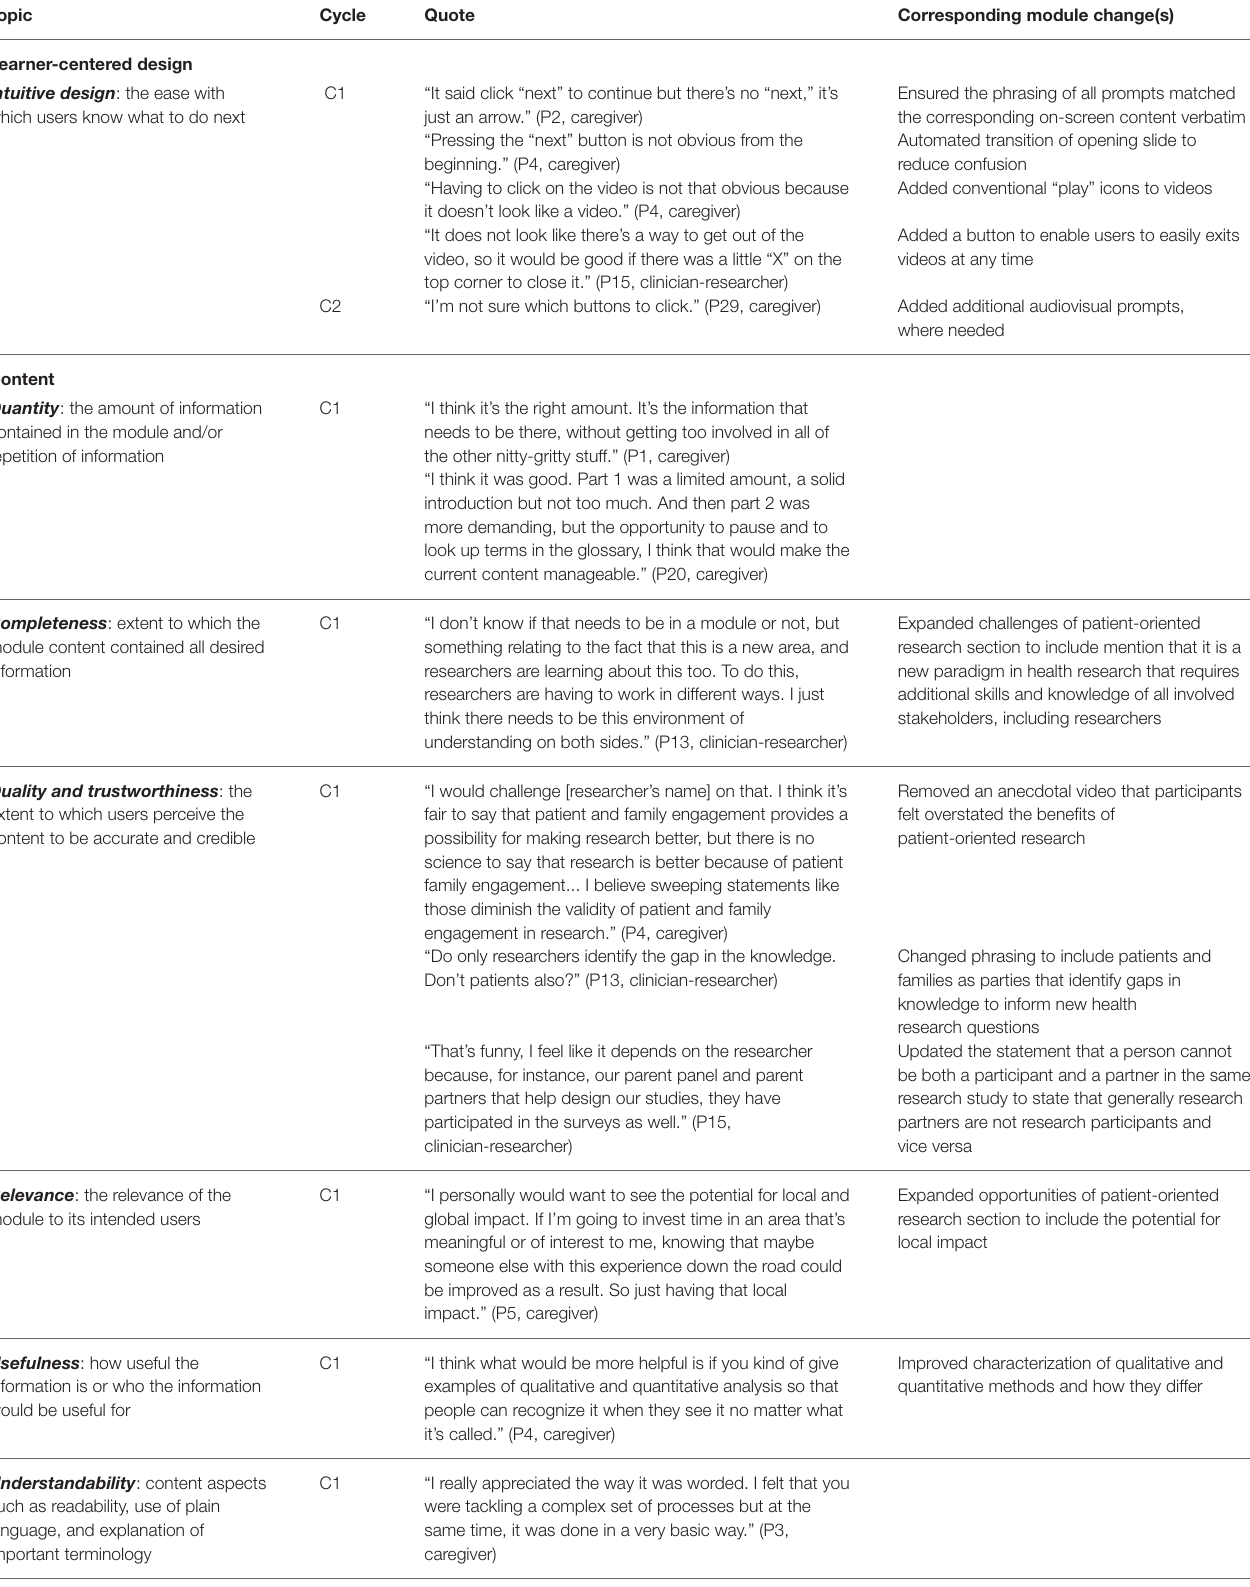
TABLE 2 | Examples of usability testing results and corresponding module changes. Topic Cycle Quote Corresponding module change(s) Learner-centered design